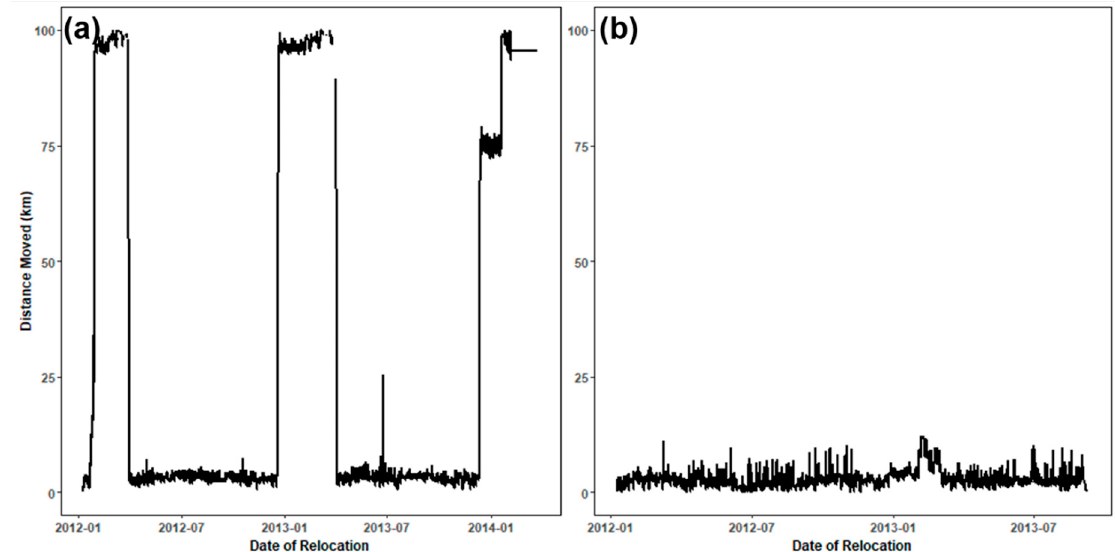
Figure 2. Net squared displacement of migratory and resident deer. The x-axis is the date of each relocation from the GPS data, and the y-axis is the displacement in kilometers from the first collected point. ( a ) The peaks and valleys demonstrate a clear migratory pattern in the net squared displacement, with the first migration occurring just after January 2012. ( b ) The relationship demonstrates little change from the initial relocation, suggesting a resident movement pattern displayed by the deer.